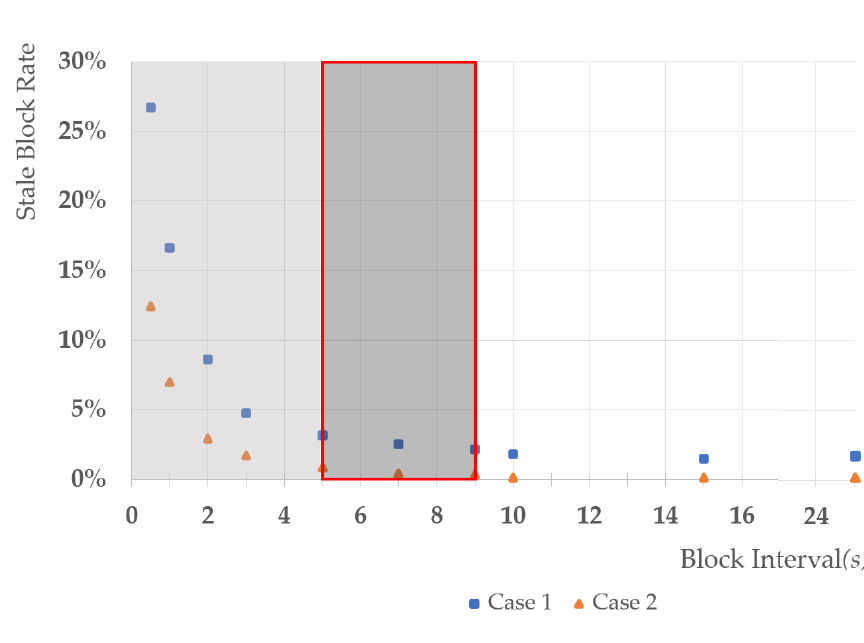
Figure 11. Diffusion Distribution: ( a ) Propagation Rate Distribution; ( b ) Stale Block Rate Distribution.